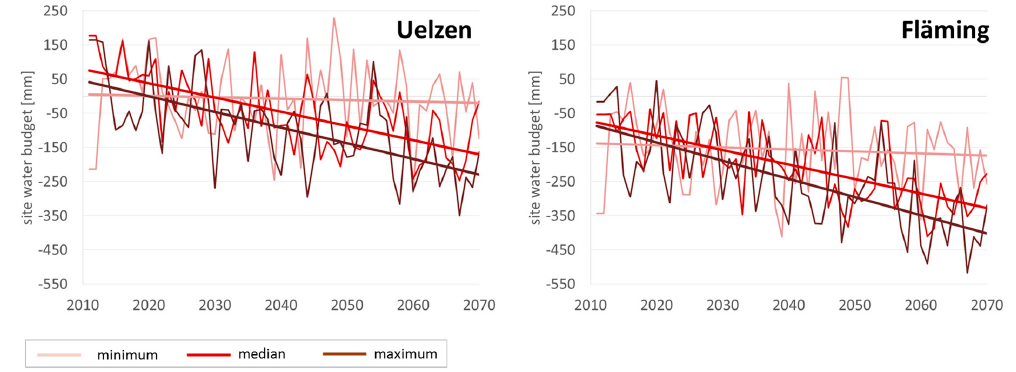
Figure 2. Site water budget over time projected with STARS using RCP 8.5 under minimum, median and maximum climate scenarios in Uelzen ( left ) and Fläming ( right ). The values are means of all individual sites.